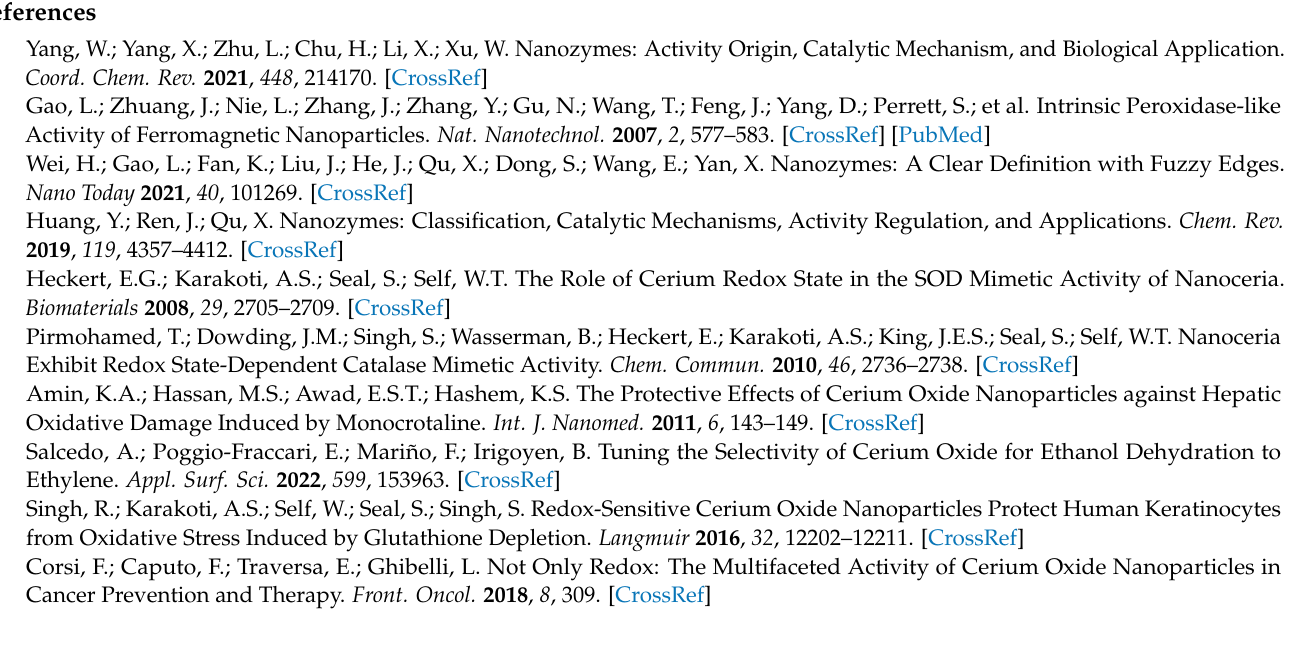
Table S2: Summary of TNP powder